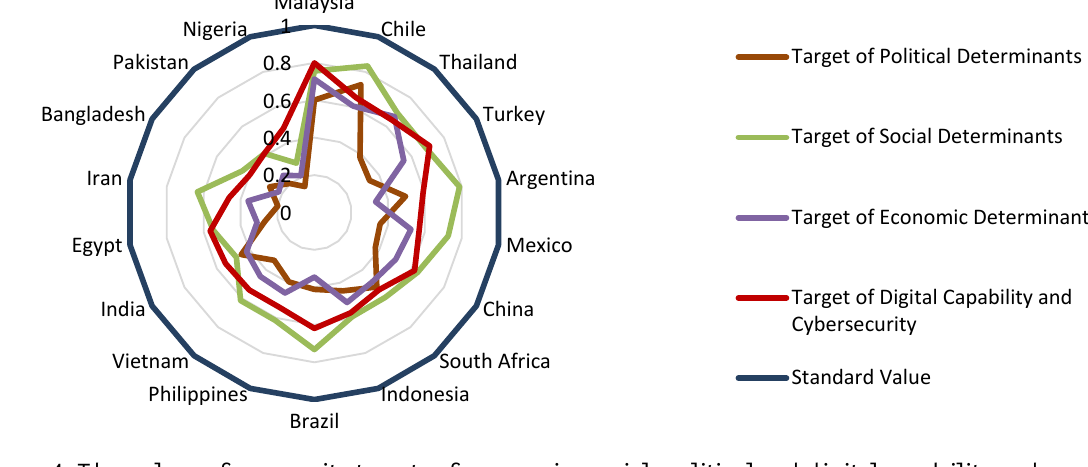
Figure 4. The values of composite targets of economic, social, political and digital capability and cybersecurity dimensions for newly industrialized countries. Source: